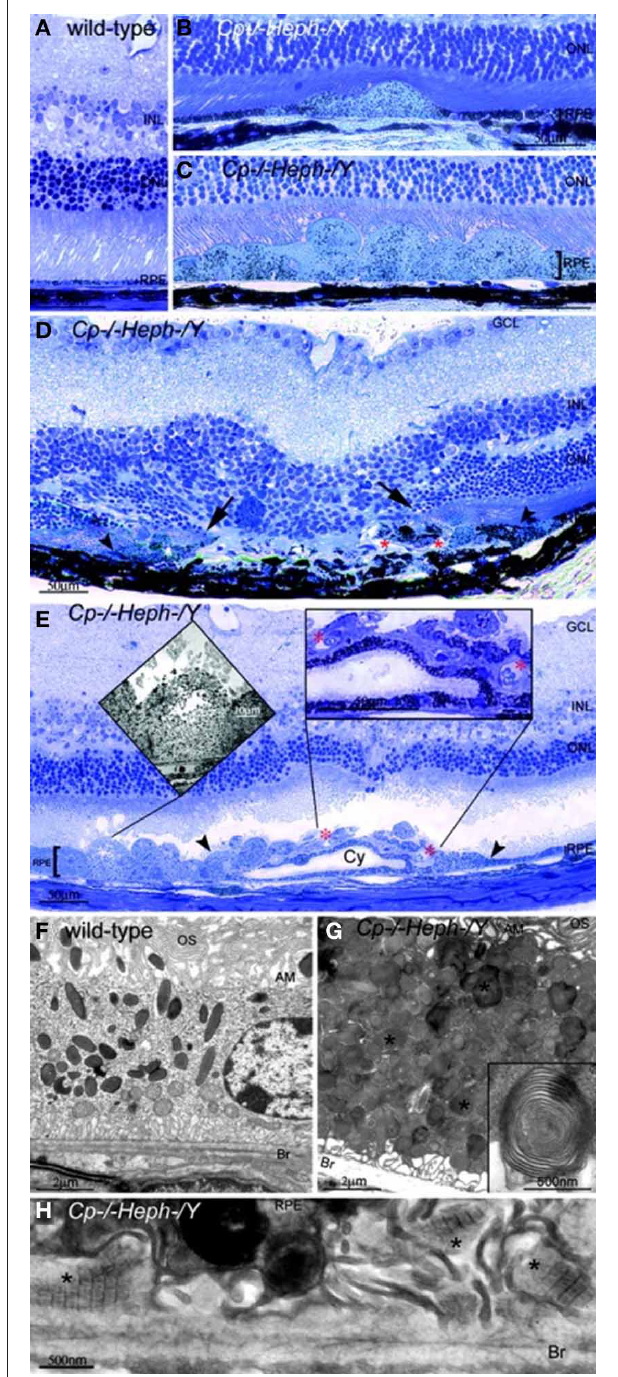
FIGURE 2 | Cp − / − Heph − /Y (9-mon-old) mice have retinal degeneration. (A) Light photomicrograph of WT retina. ( B and C ) Cp − / − Heph − /Y retina has focal patches of hypertrophic RPE cells in some regions (B) and confluent hypertrophic RPE cells in other areas (C) . (D) In an area of RPE hyperplasia (demarcated by arrowheads), Cp − / − Heph − /Y retinas have local photoreceptor degeneration [demarcated by arrows in the outer nuclear layer (ONL)] and subretinal neovascularization (red ∗ ). (E) In an area of hypertrophic, hyperplastic (area demarcated by arrowheads) RPE cells,